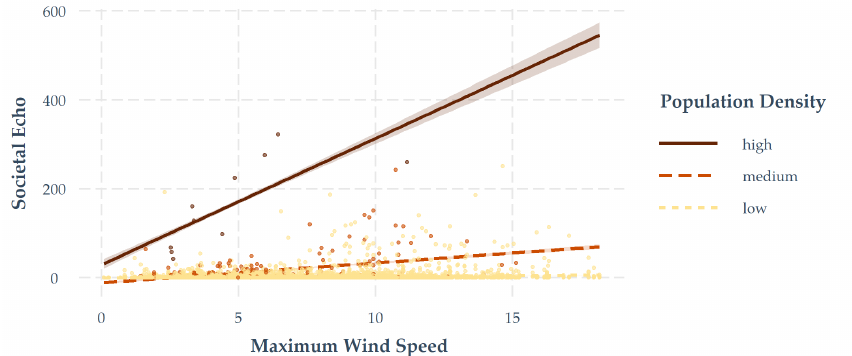
Figure 10. The population density moderates the linear relationship of maximum wind speed and the societal echo during the storm peak phase of 18–19 January 2018. In regions with high and medium population density, a positive (r = 0.75, p ≤ 0.01) and moderate (r = 0.41, p ≤ 0.01) relationship was observed. Whereas, in low populated regions, the relationships was weak (r = 0.16, p ≤